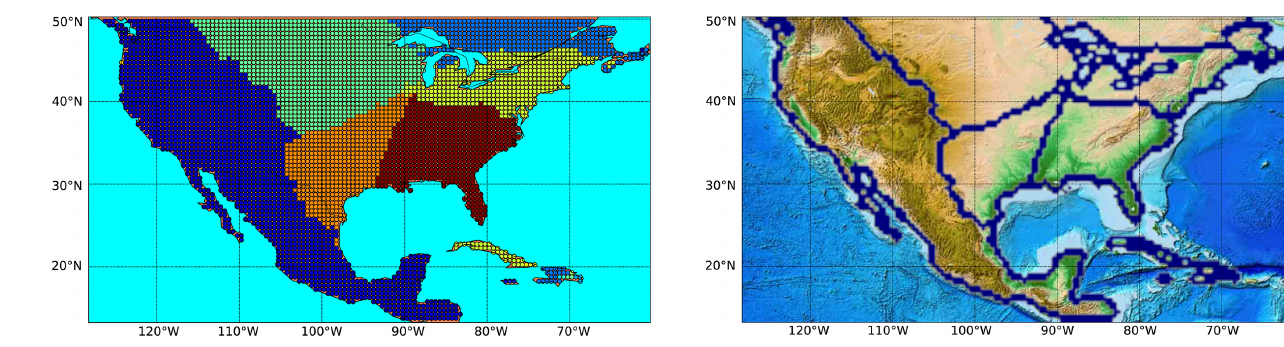
Figure 4. Community structure for the network constructed with the grid points with θ and latitude φ in the intervals − 128 ◦ ≤ θ ≤ − 60 ◦ and 30 ◦ ≤ φ ≤ 70 ◦ of the temperature database. Grid points colored with the same color correspond to nodes belonging to the same network community.